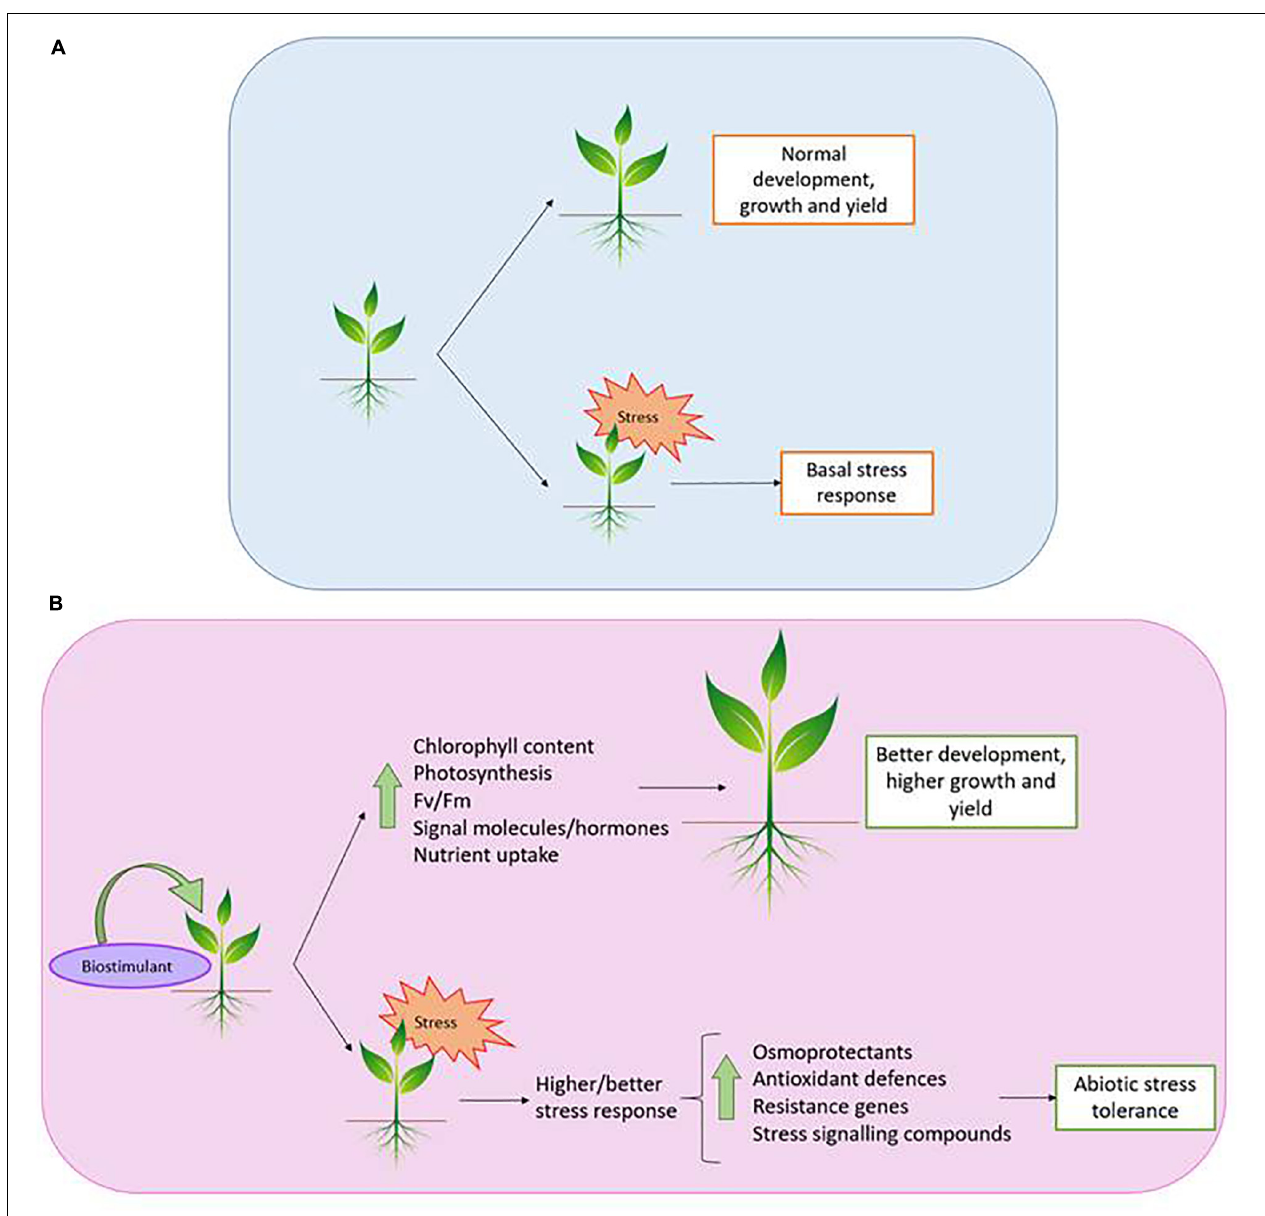
FIGURE 1 | Plant response against stress. Without (A) and with biostimulant (B)